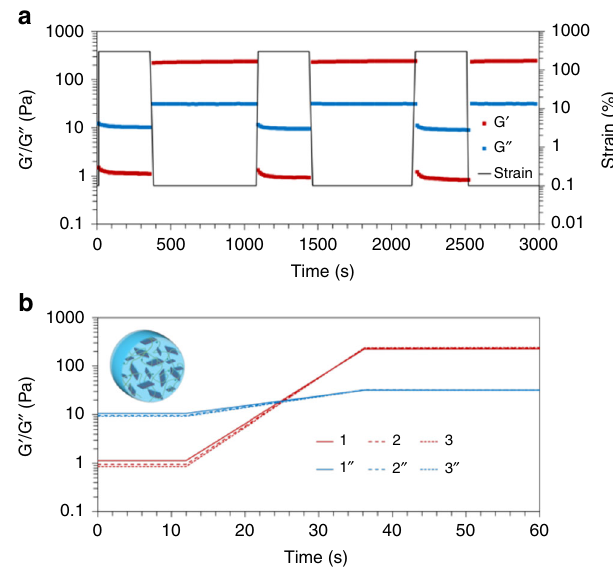
Fig. 4 Self-healing properties of calcium-alginate hydrogels containing PLLA 35 - b -PDMAEMA 315 platelets. a Step strain measurements of NC calcium-alginate containing platelets (0.12 wt%) over three cycles ( ω = 10 rad s − 1 ) and b overlaid zoom of the recovery of the material properties after each of three cycles, indicated by G ′ in a continued line and G ″ in a dashed line (the numbers indicate the